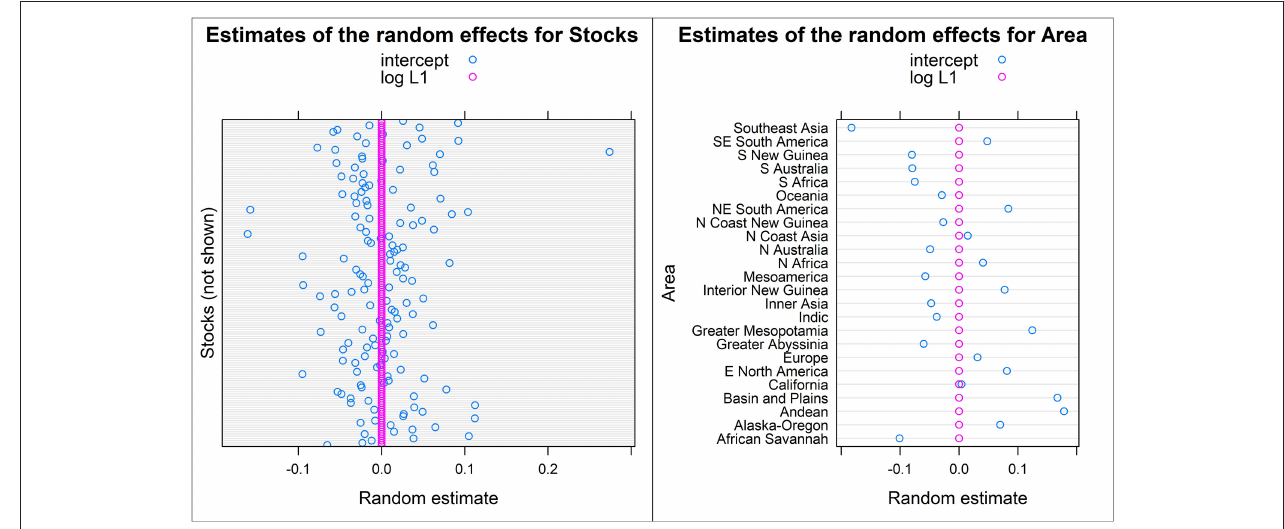
FIGURE 5 | Random effect variation of model SYNTHESIS.L1. The left panel shows the estimates for the random intercept and random slope over Stocks and the panel on the right shows the estimates for the random intercept and random slope over Area.